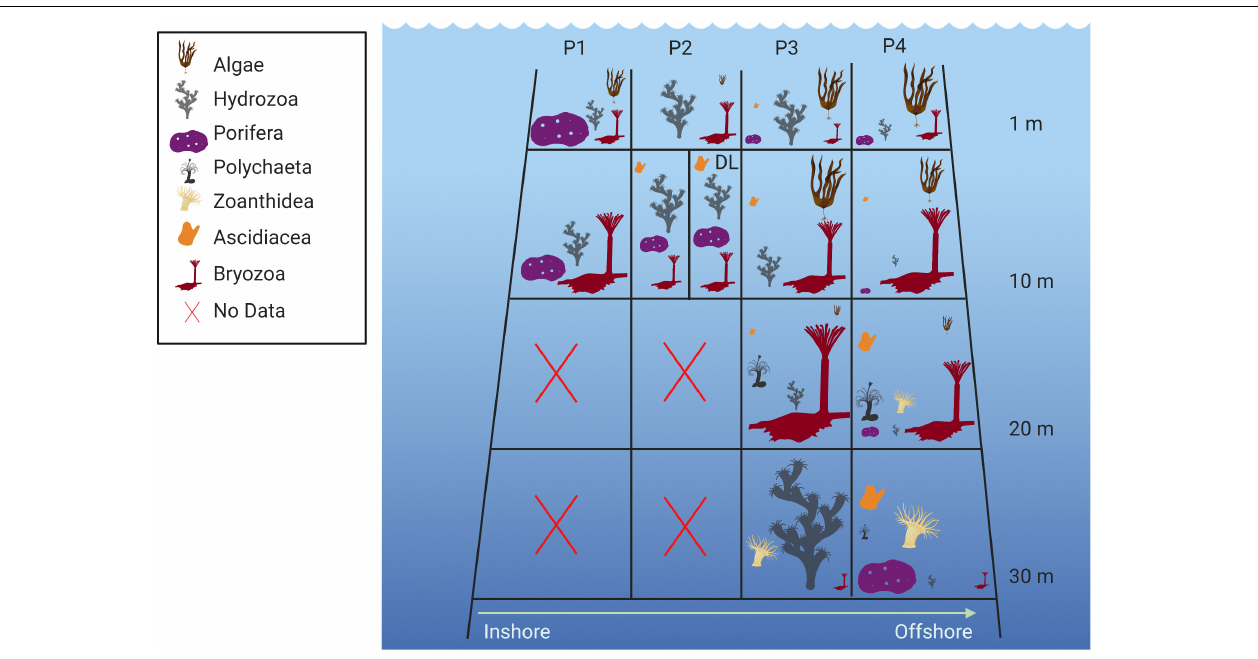
FIGURE 3 | Zonation of fouling communities on four platforms (P1–P4) off the Louisiana coast from Lewbel et al. (1987). The size of the respective symbols represents the relative contribution of the taxon to the percent cover. The platforms were located in 12 to 46 m of water and fouling communities were sampled at 1 and 10 m depth at all platforms and additionally at 20 and 30 m depth at P3 and P4. At P2, an additional sampling station (P2-DL) was established above a produced water outlet. Note that scleractinian corals were not sampled on P1–P4 but were reported (but not quantitatively sampled) from other platforms in the